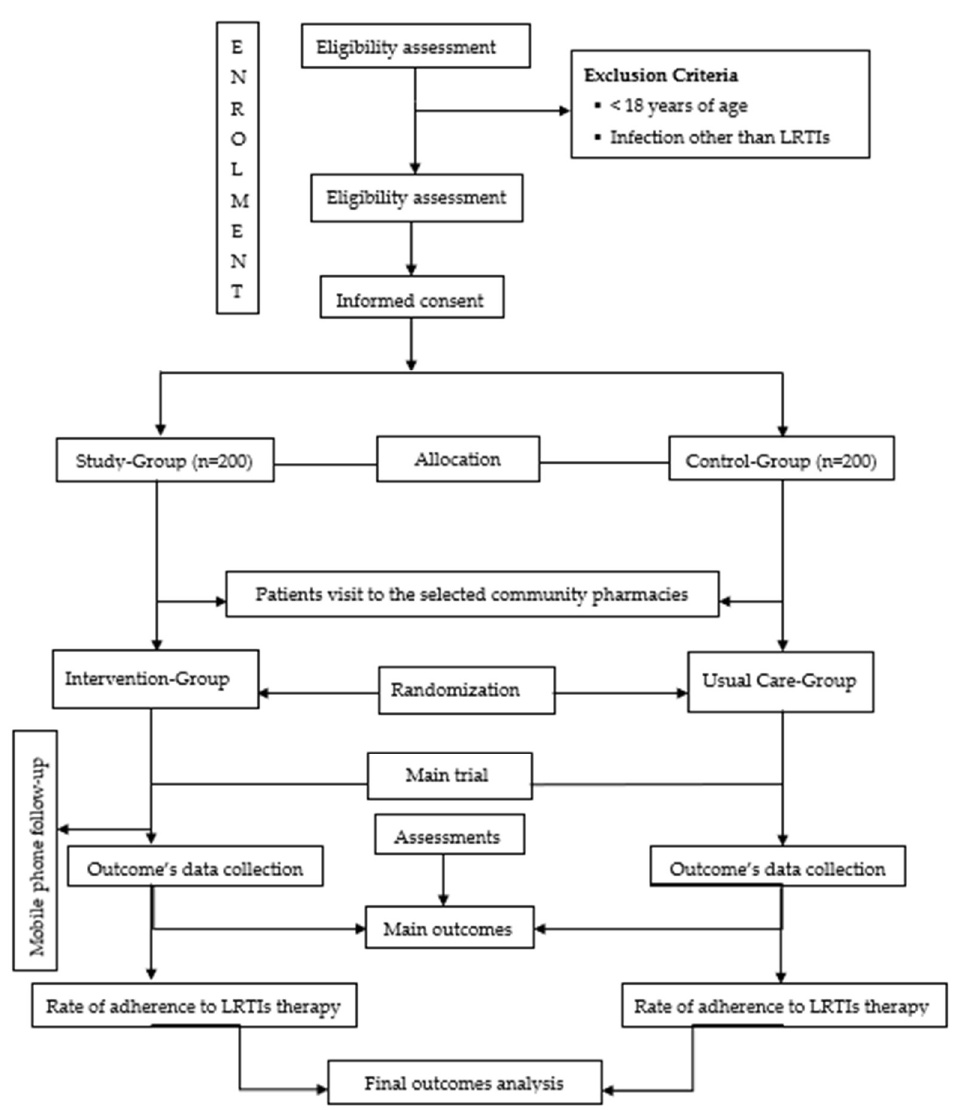
Figure 1. Schematic flow diagram of the trial.